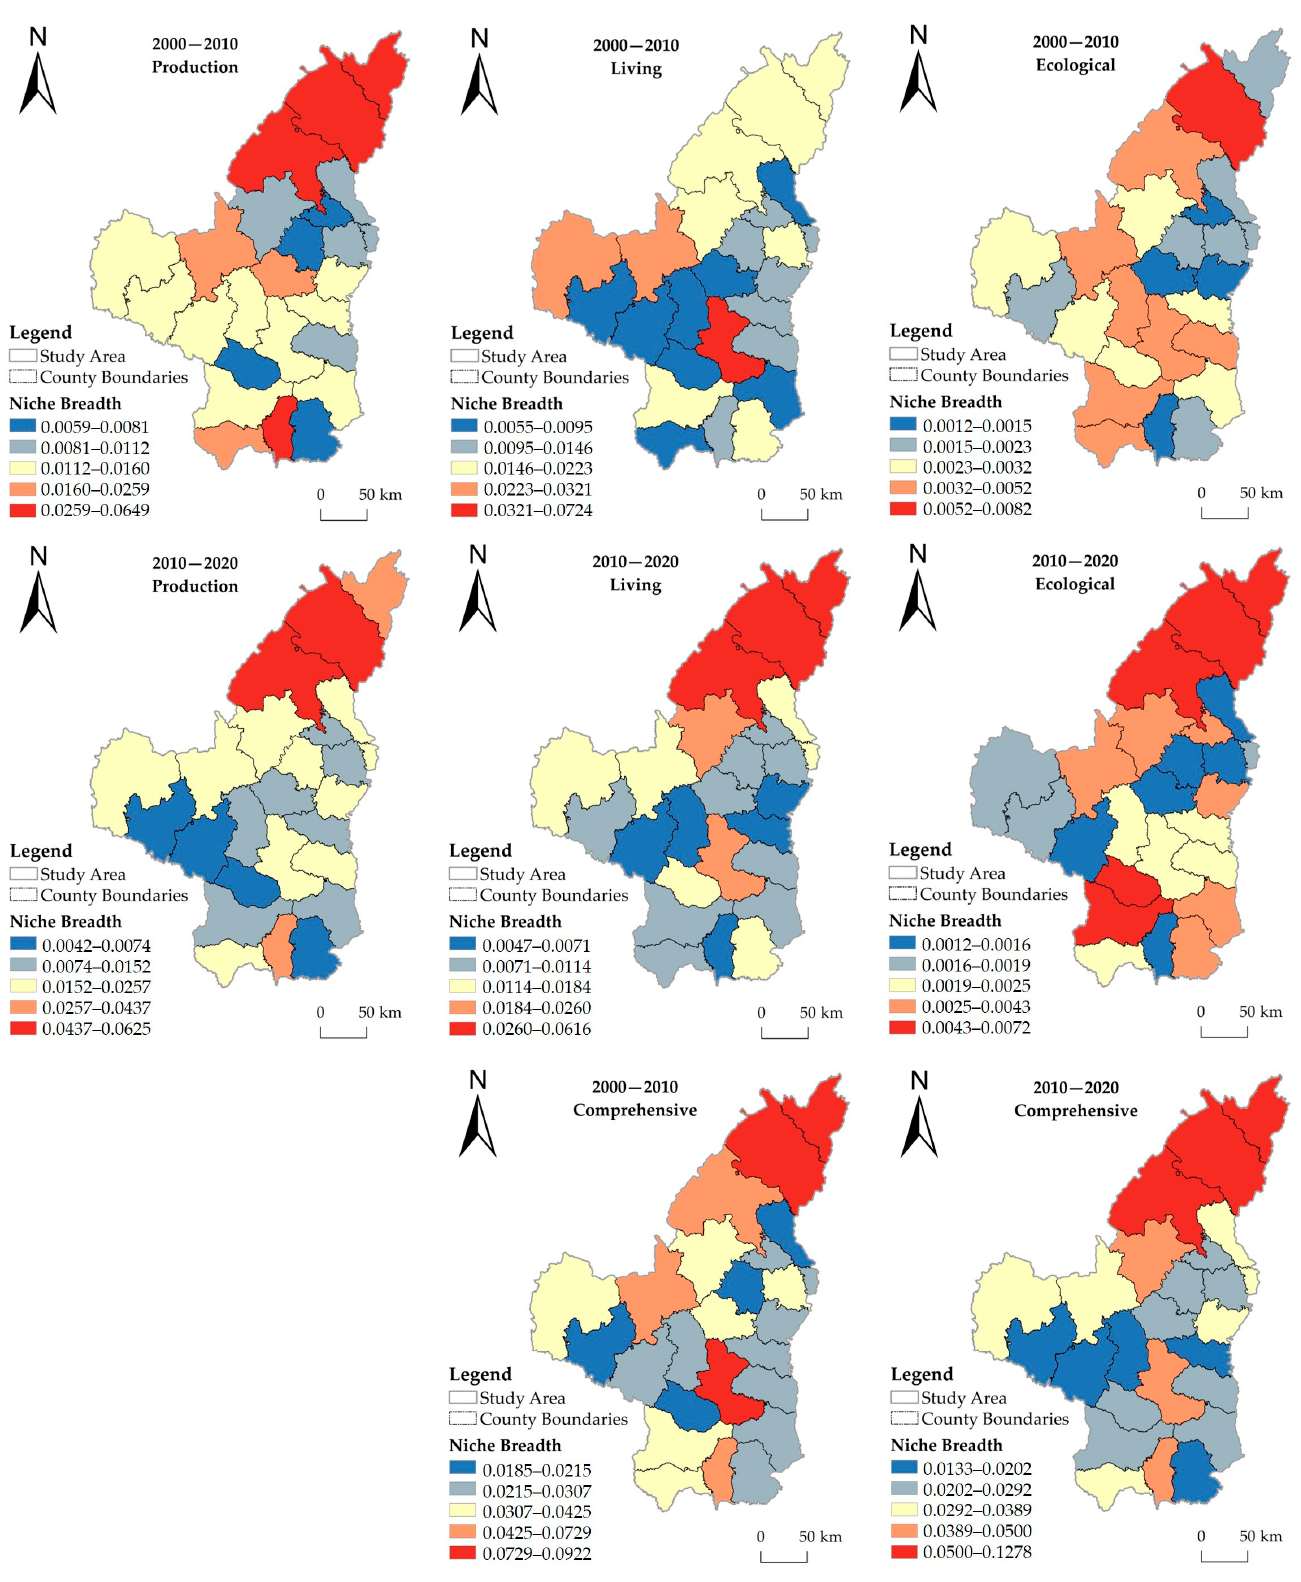
Figure 3. Spatial distribution of niche breadth of human settlement environment in northern Shaanxi from 2000 to 2020.